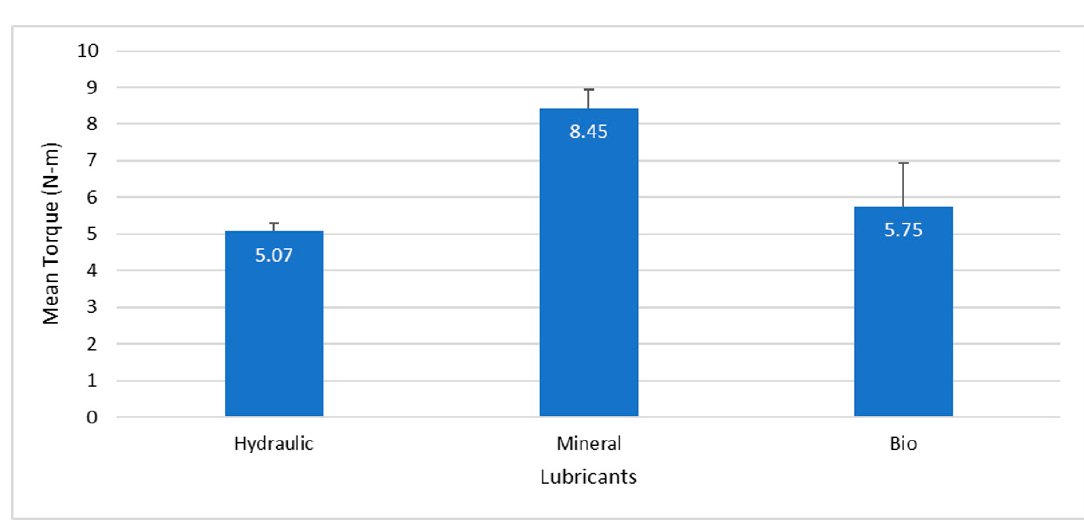
Figure 8. Average tapping torque per lubricant categories.